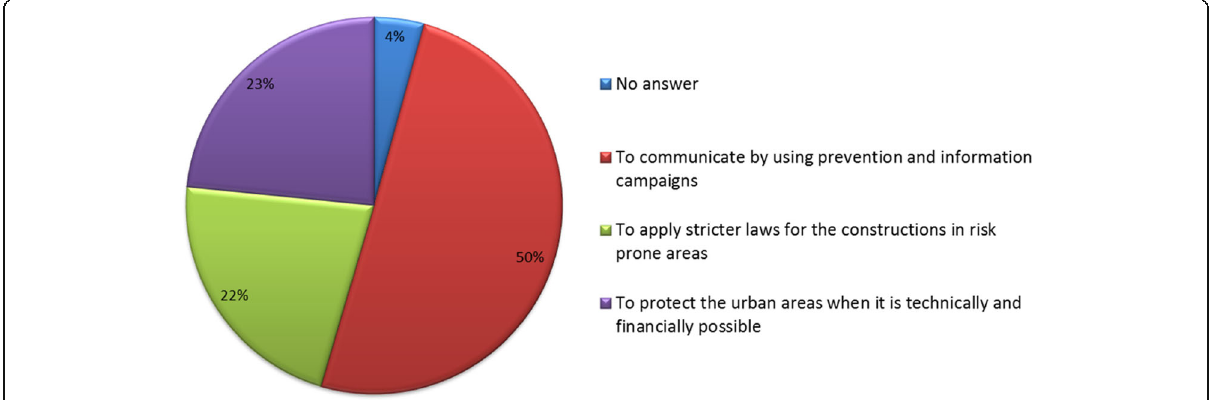
Fig. 5 Answer to the question: “ To better cope with the risk of lahars, we have to … ? ” ( N = 209)